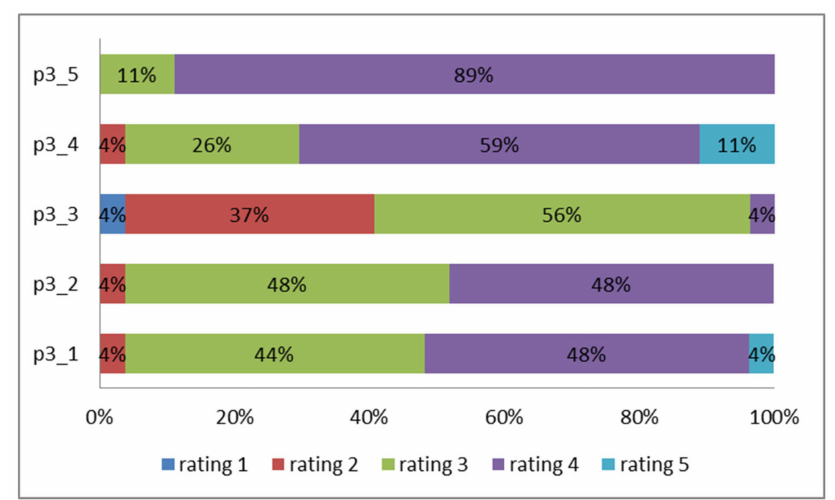
Figure 4. Assessment of barriers / obstacles to the implementation of CE in the coal power industry.